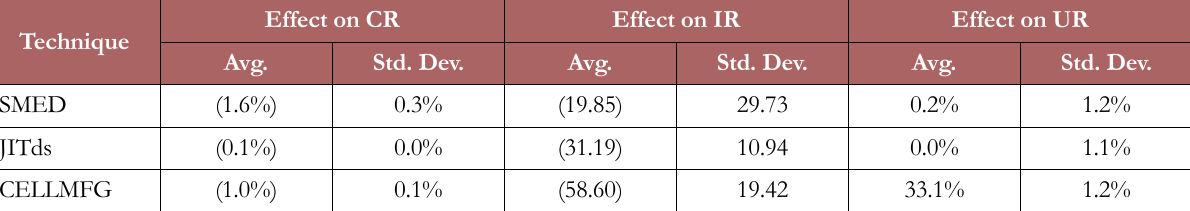
Table 9. Summary of